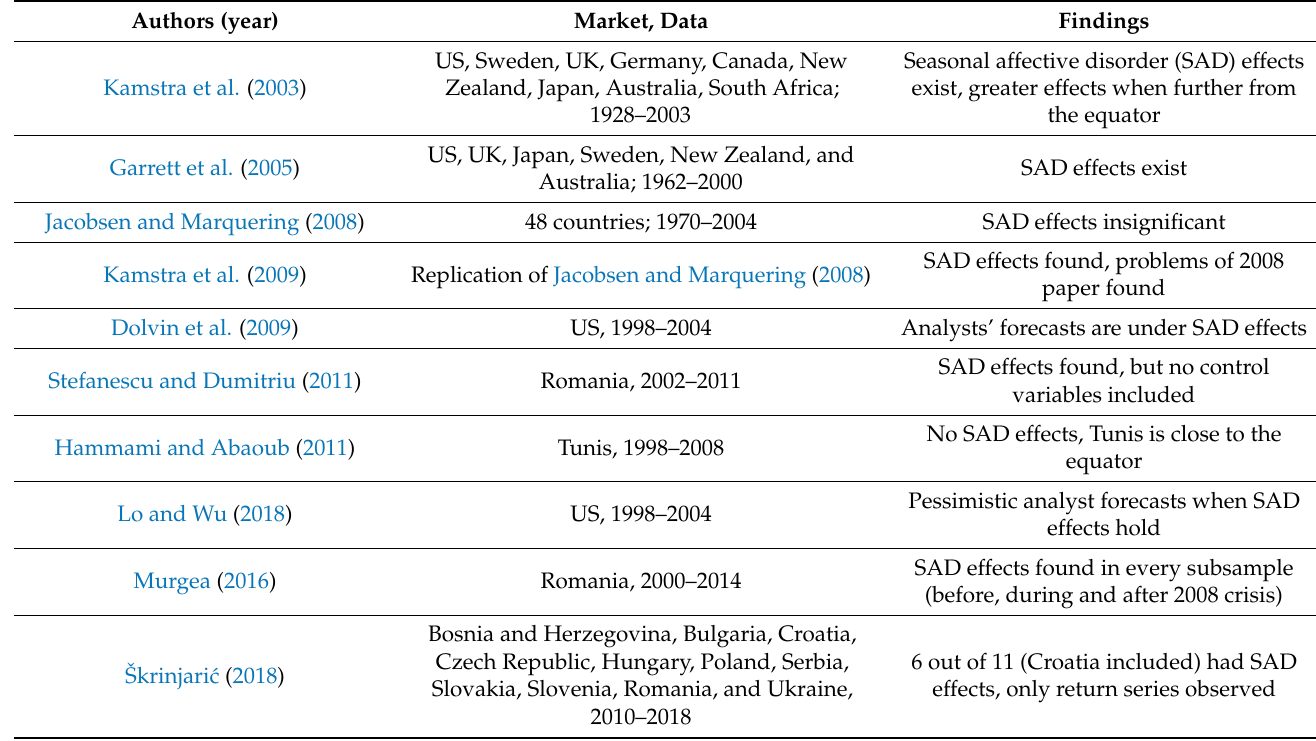
Table 1. Summarization of previous